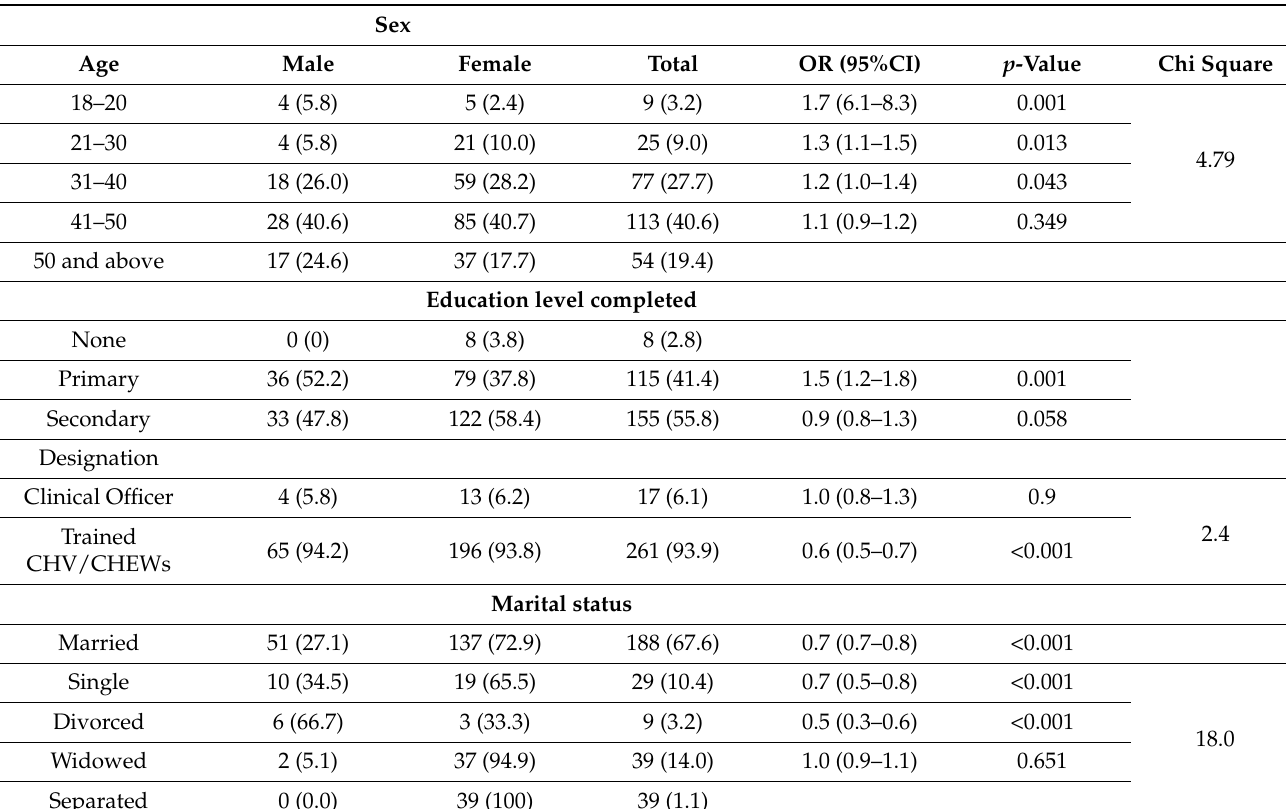
(Table 1). Sex differences among community health workers aged 18–20 years and 50 years and above were less prominent, with the respective ratios being 1.3 and 2.1. Community health workers who had completed secondary school had the highest sex ratio of 3.7; however, greater proportions of females were found among women who did not attain any formal education (100%). Those who had completed primary school were 1.5 times more likely to be female (OR = 1.5; 95% CI, 1.2 to 1.8, p < 0.001) than male in this category. Table 1. Demographic characteristics of community health